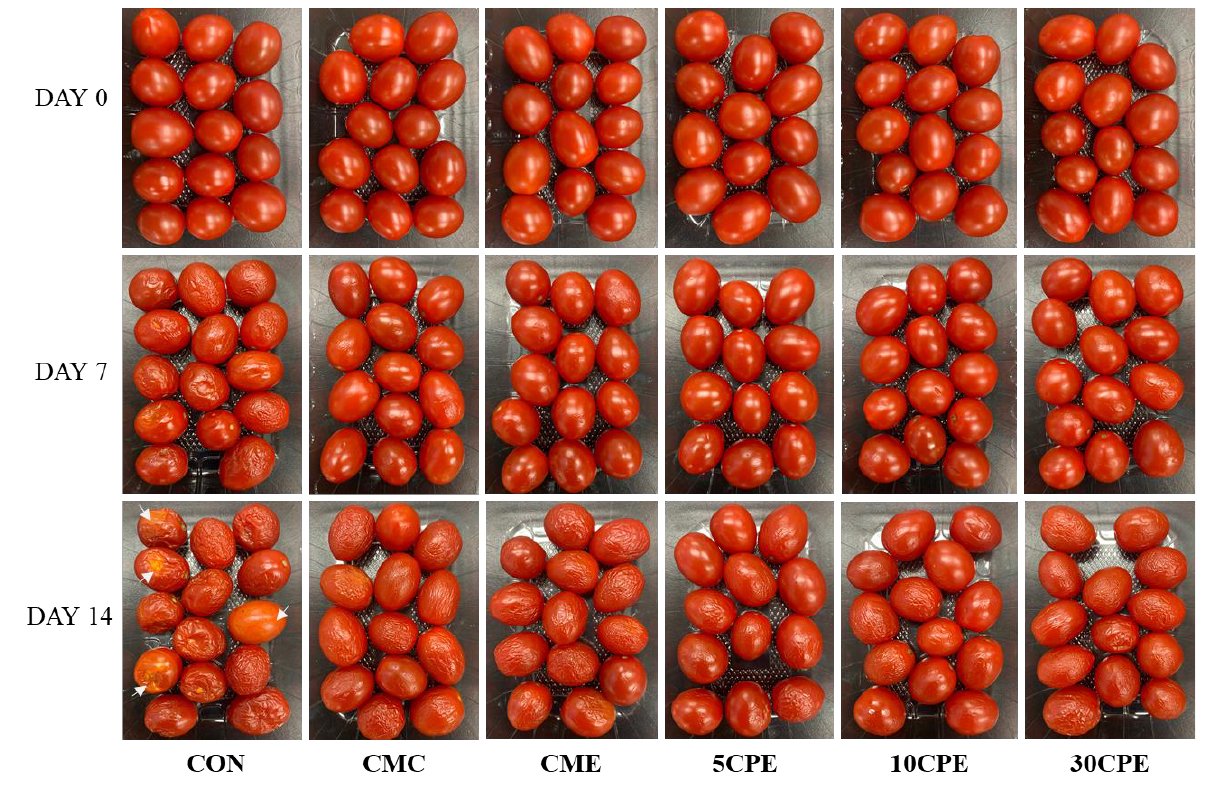
Figure 10. Visual appearance of uncoated and OLP/CMC-coated cherry tomatoes during storage at 30 °C for 14 days.